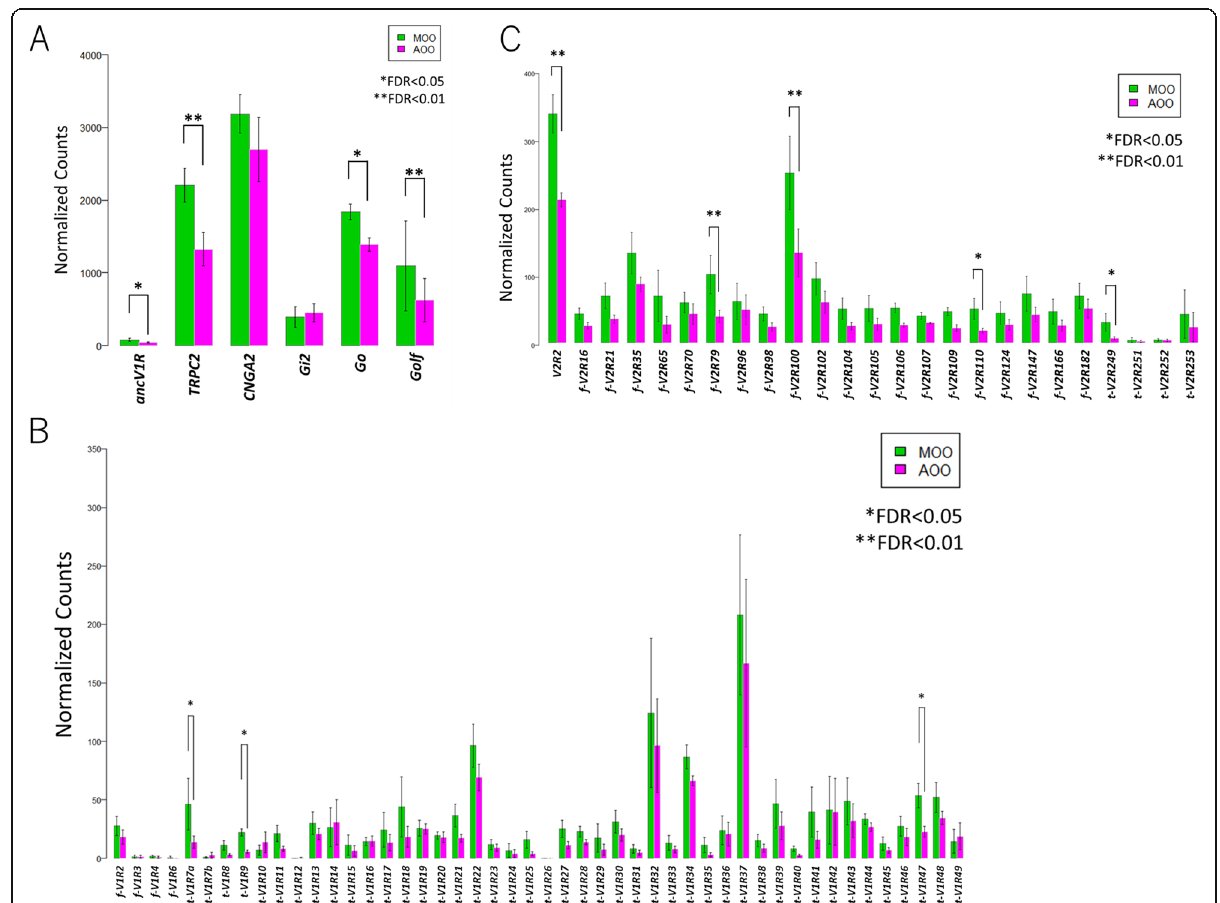
Fig. 2 RNA-seq analysis of the MOO and AOO of bichir. Comparison of the expression levels of ( A ) several landmark genes related to the VNO and MOE, ( B ) V1R s and ( C ) V2R s. The vertical axis shows the normalized number of RNA-seq reads mapped to each gene region (RPM), and the horizontal axis shows gene names. Bars in green and magenta indicate the MOO and AOO, respectively (*: FDR < 0.05, **: FDR <